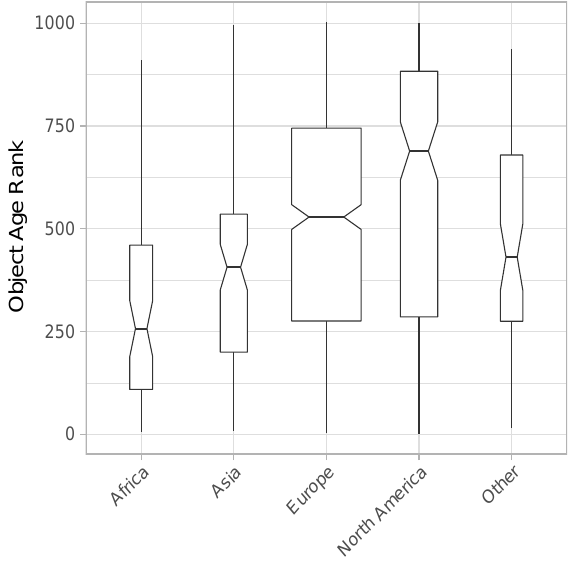
Figure 5. Object age in relation to the continents the OSM LULC objects were located. Africa contained significantly younger objects while North America contained significantly older